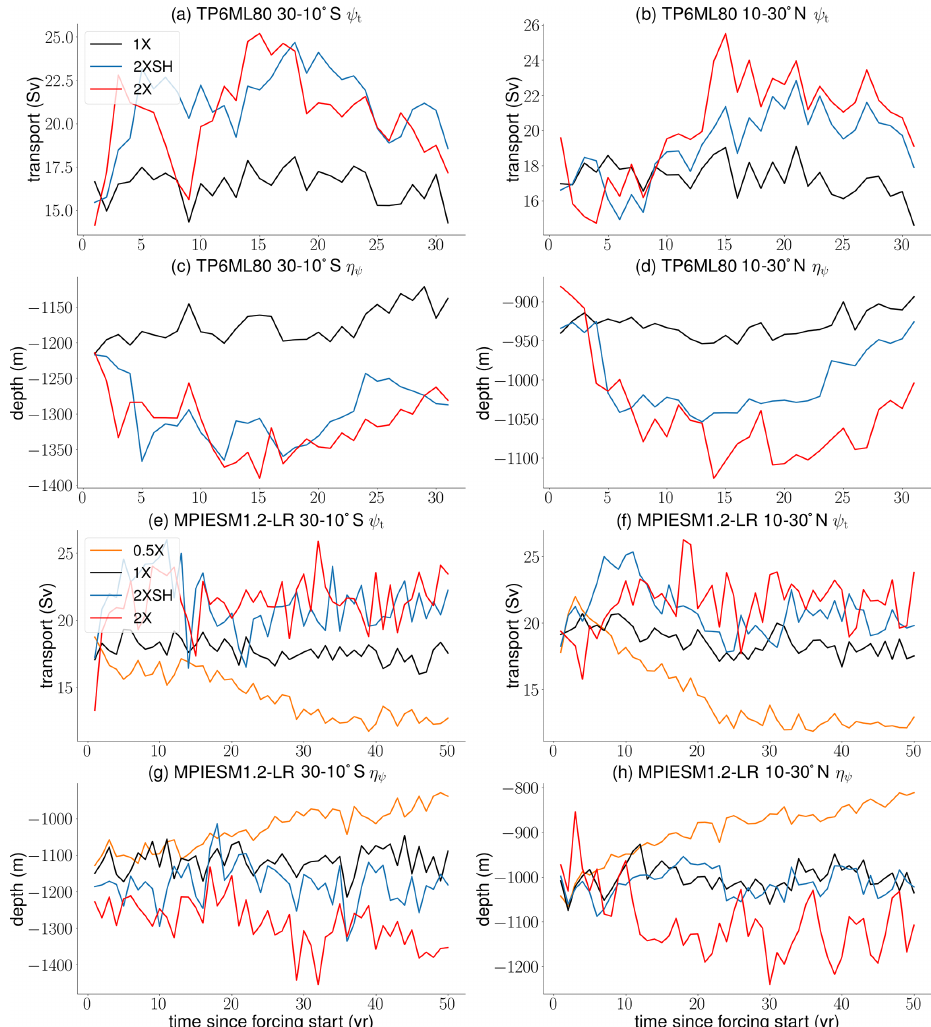
Figure 10. The TP6ML80 time evolution (30–10 ◦ S, 10–30 ◦ N) of (a, b) maximum overturning and (c, d) the level of no motion after the forcing is switched on. The MPIESM1.2-LR time evolution (30–10 ◦ S, 10–30 ◦ N) of (e, f) maximum overturning and (g, h) the level of no motion after the forcing is switched